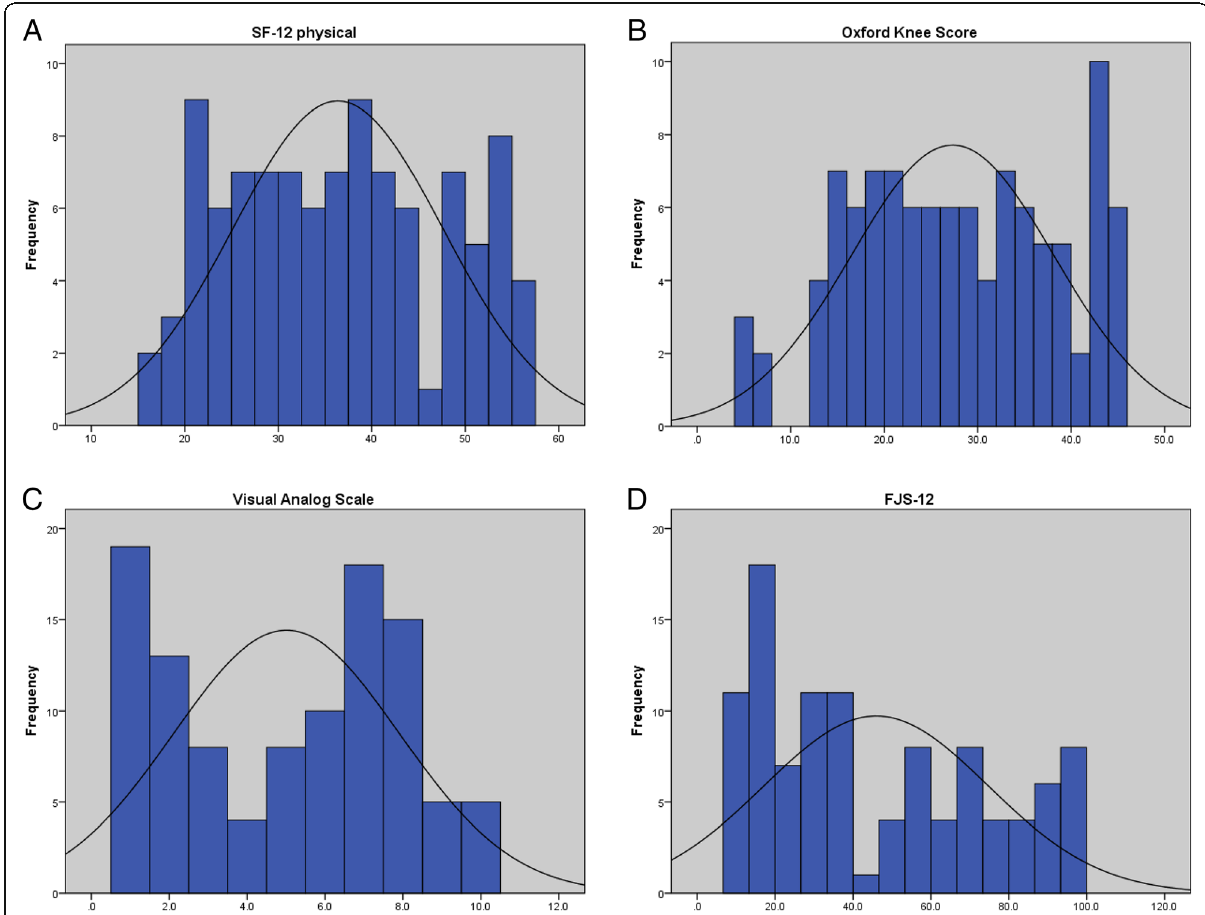
Fig. 1 Scatter plot correlating the first and second call on forgotten joint score